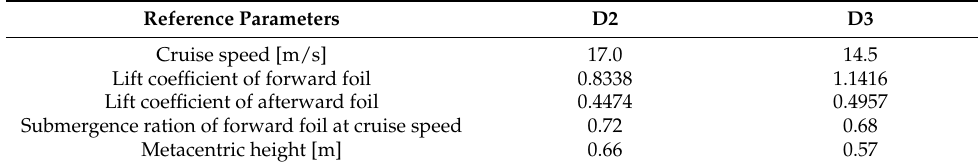
Table 3. Main data of foils at the cruise speed.